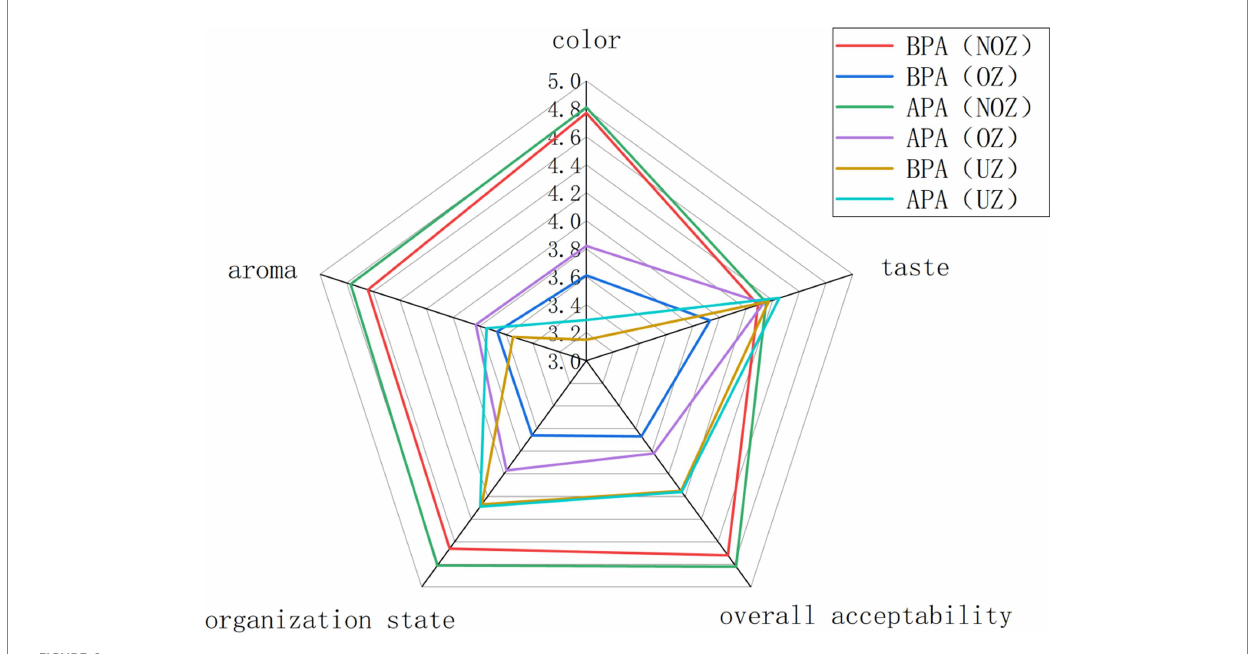
FIGURE. 9 Sensory evaluation of products in different parts of